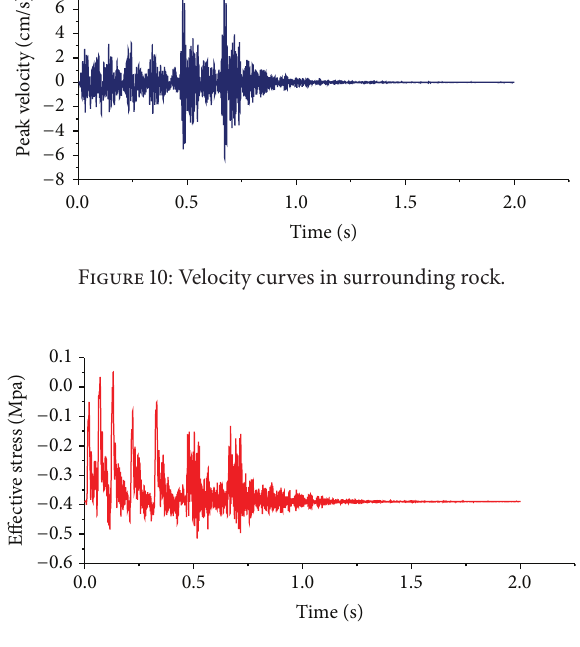
Figure 11: Tensile stress curves in surrounding